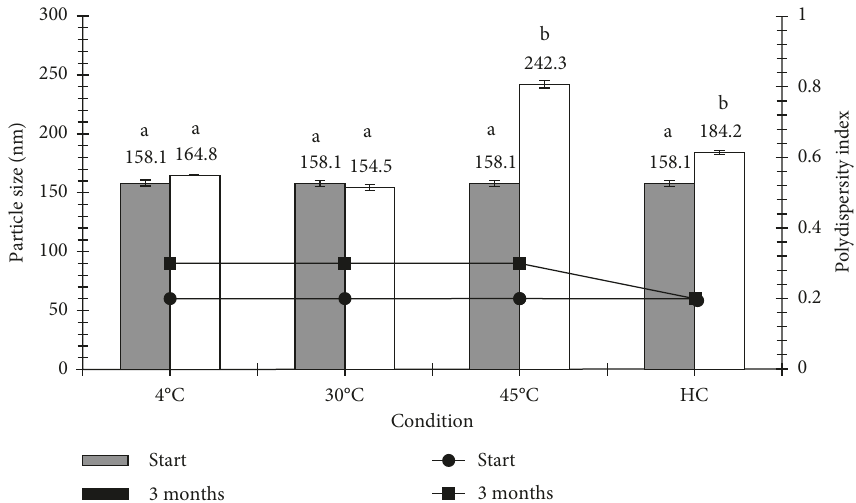
Figure 5: Mean particle size and PDI of CP-loaded NLCs before and after the stability test at different conditions. Different letters mean significant difference ( p < 0 .